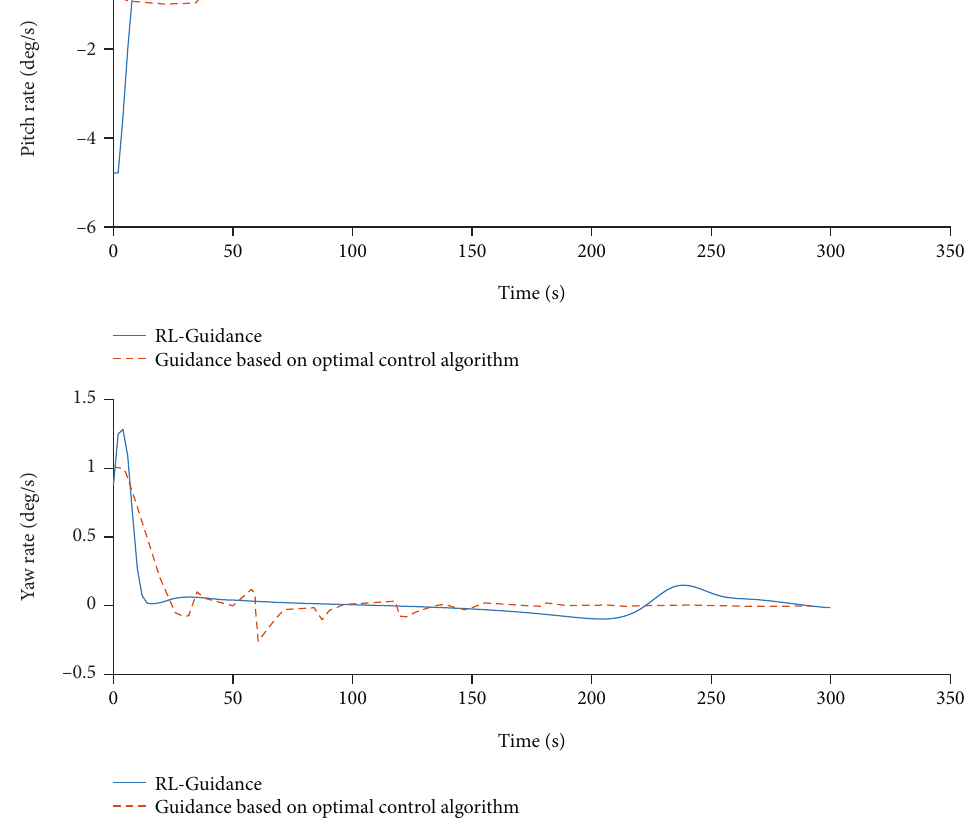
Figure 10: Control comparison of RL-guidance and guidance-based on optimal